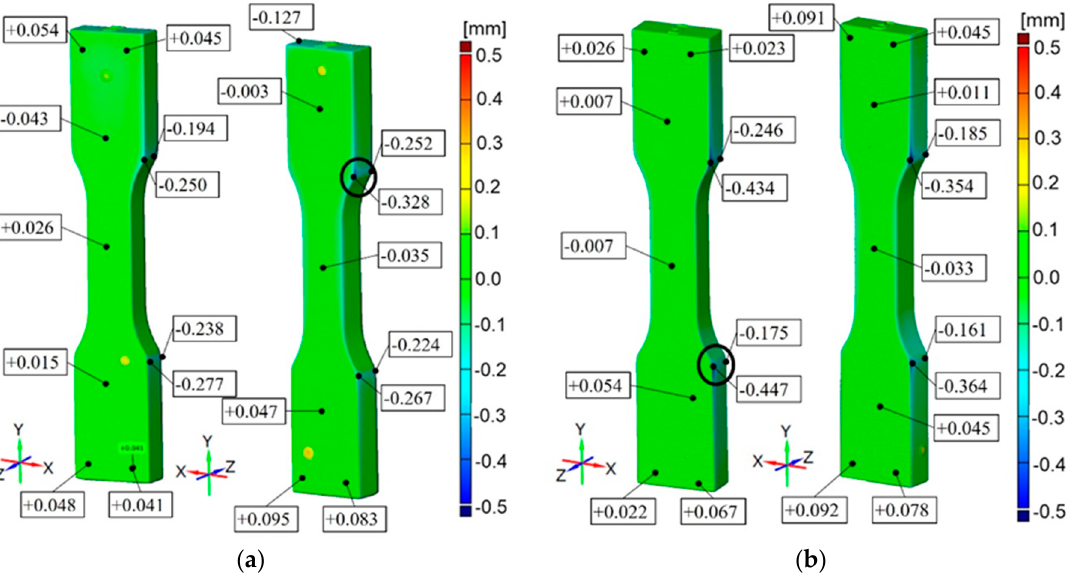
Figure 11. Geometric accuracy [mm] for the specimens made of Durus White material printed with nominal layer thickness 0.016 mm: ( a ) Raster orientation: horizontal (X-axis), specimen ID: 2; ( b ): Raster orientation: vertical (Z-axis), specimen ID: 5.